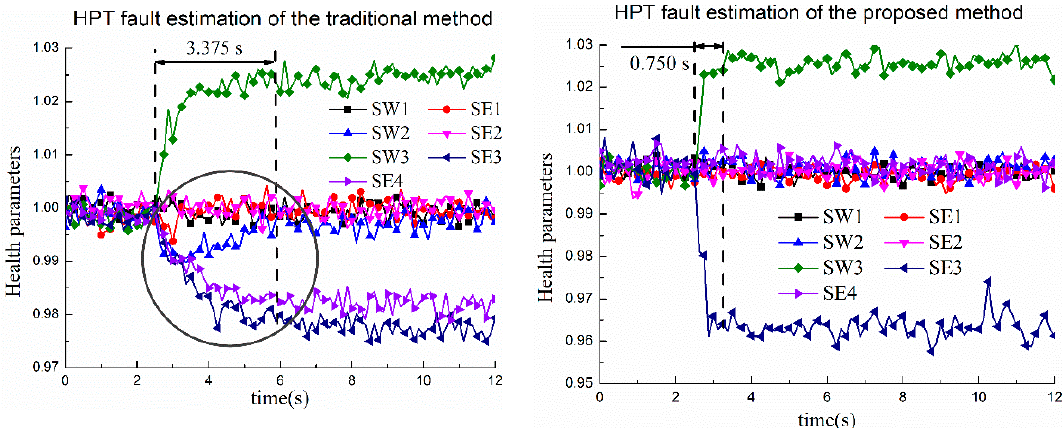
Figure 12. The comparison of the traditional and the proposed methods in Case 2.